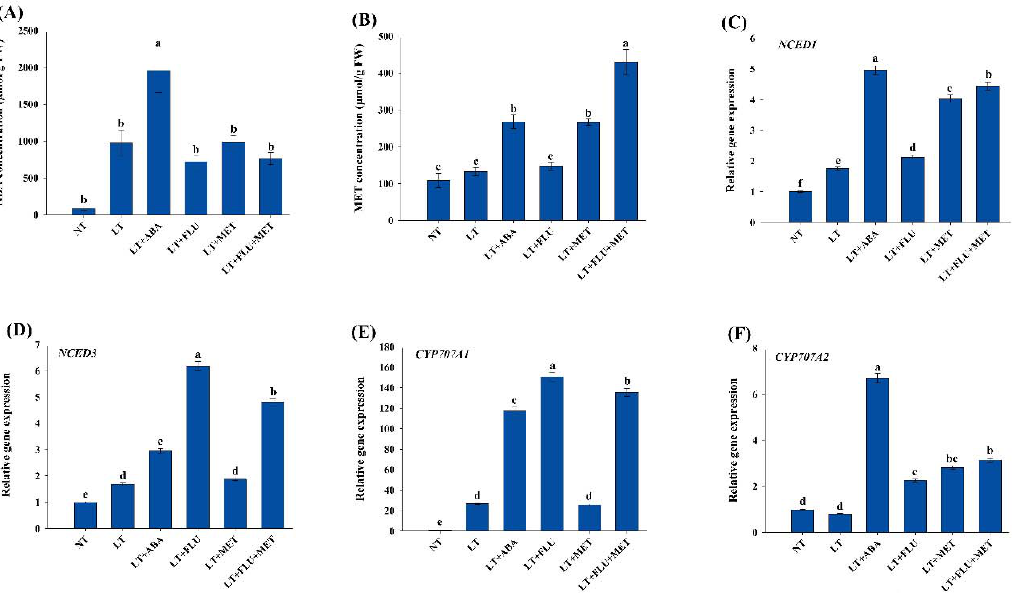
Figure 8. Effects of exogenous melatonin and ABA treatment on the endogenous ABA concentration ( A ), MET concentration ( B ), relative expressions of NCED1 ( C ), NCED3 ( D ), CYP707A1 ( E ), and CYP707A2 genes ( F ) in strawberry seedlings under cold stress. Plants treated with distilled water under the normal conditions (25 °C) served as control (NT). The strawberry seedlings were pretreated with distilled water (LT), 100 μ M ABA (LT + ABA), 50 μ M fluridone (LT + FLU), 100 μ M melatonin (LT + MET), and 50 μ M fluridone + 100 μ M melatonin (LT + FLU + MET) 3 times in a two ‐ day interval and then exposed to cold stress for 2 days. Graphs represent the mean of three biological replicates. Values labeled with different letters indicate significant differences among treatments at ( p ≤ 0.05) by LSD.